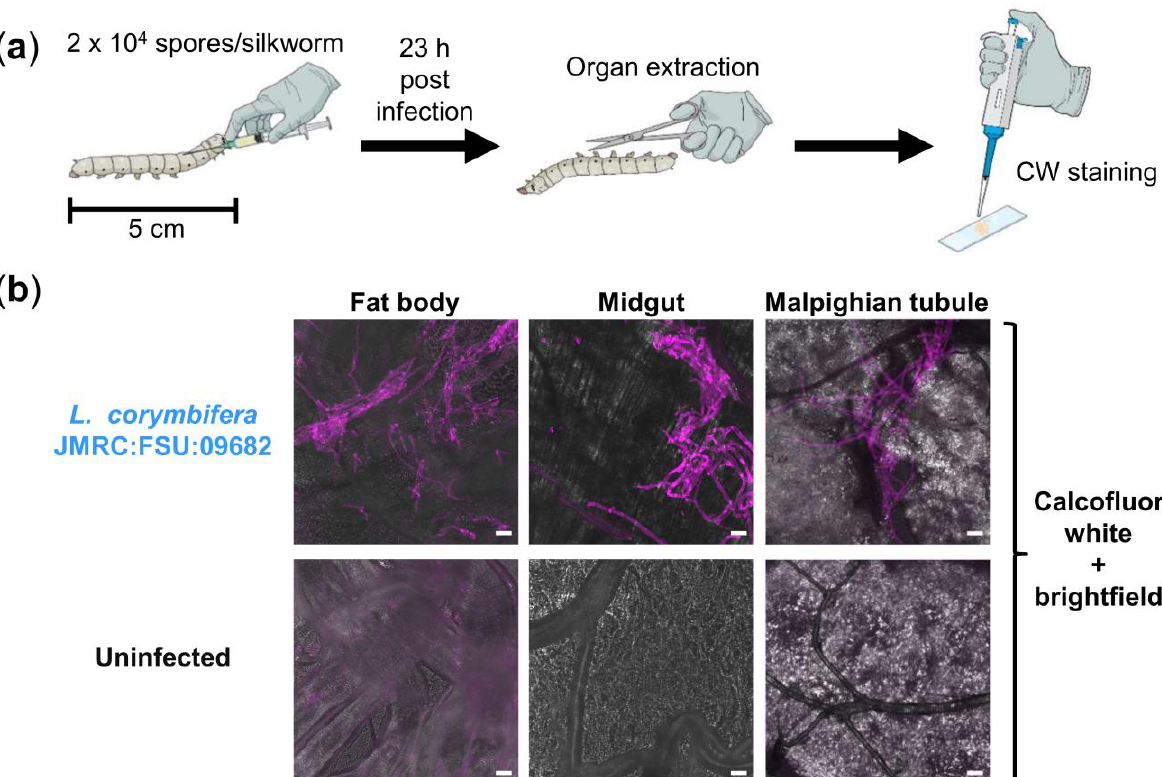
Figure 2. Visualization of fungal burden in silkworms infected with L. corymbifera . ( a ) Illustration of experimental setup; CW: Calcofluor white; ( b ) merged images (calcofluor white in violet + brightfield) show fungal burden in different organs of infected silkworms at 23 h post infection, compared to an uninfected control; scale bars represent 20 µm.